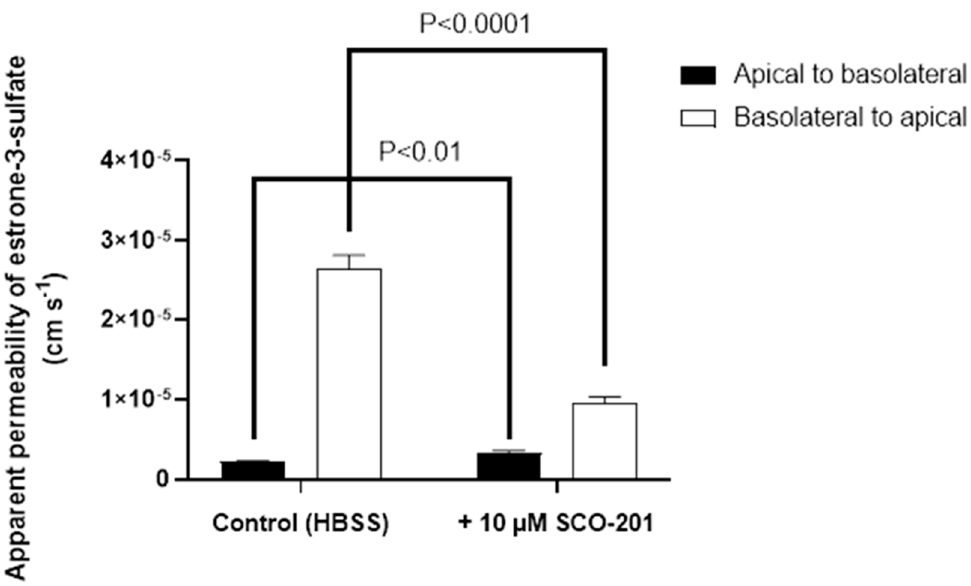
Figure 3. Bidirectional transport of estrone-3-sulfate across Caco-2 cell monolayers in the presence or absence of 10 µM SCO-201. Permeability (Papp) values were calculated from steady-state fluxes as described the in the Methods section (Section 2.5). Filled bars show PA-B (apical to basolateral) values, open bars show PB-A (basolateral to apical) values. Values are means ± SD of three individual passages, with three individual permeable supports for each transport direction per passage ( n = 3 − 5, total N = 9). The p -values are indicated in the figure.